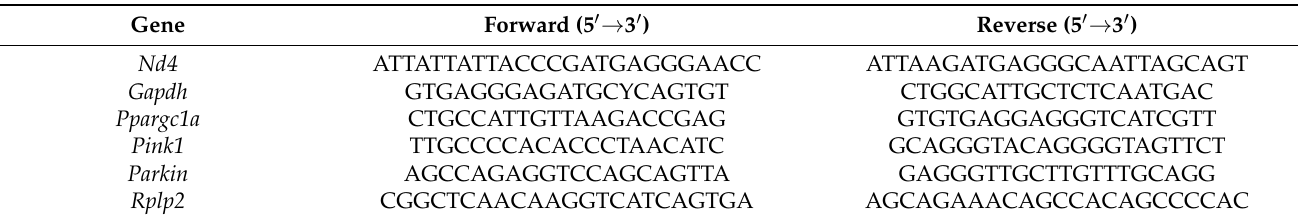
Figure 1. Scheme for induction of diabetes mellitus ( a ), intraperitoneal glucose tolerance test ( b ) in experimental group of animals. The total area under the curve (AUC) during IPGTT ( c ). Heart rate of animals in four experimental groups ( d ). The values are given as mean ± SEM ( n = 5). Table 1. List of gene-specific primers for RT-PCR